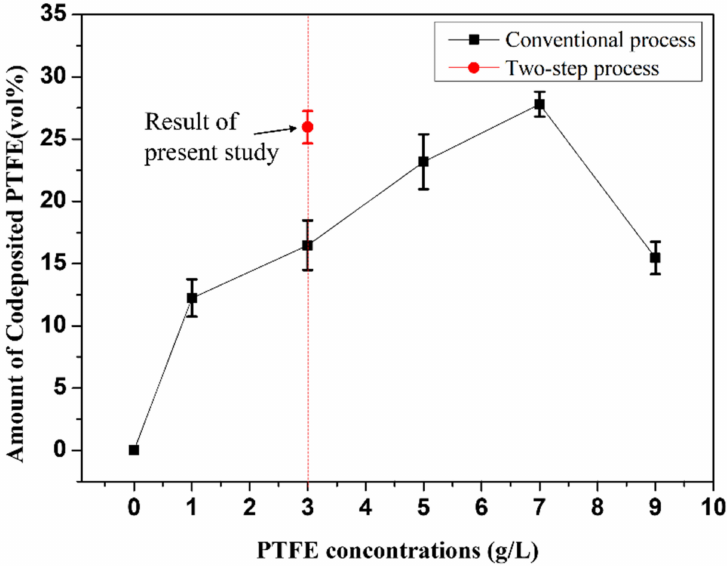
Figure 3. PTFE content in the Ni-P-PTFE plating layer for various PTFE concentrations and the two processes compared herein.